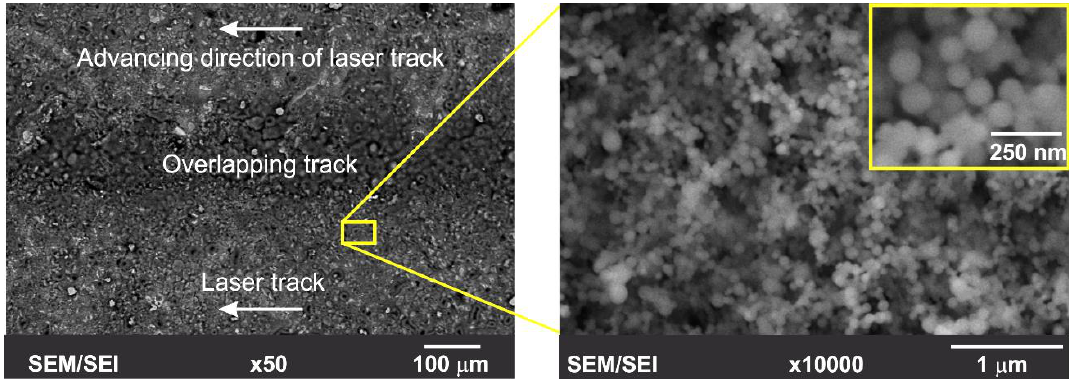
Figure 2. SEM morphology of the LSA TiC / TiB 2 / Al coating processed with LED of 13.3 J / mm 2 at lower magnification (left) and at higher magnification (right).